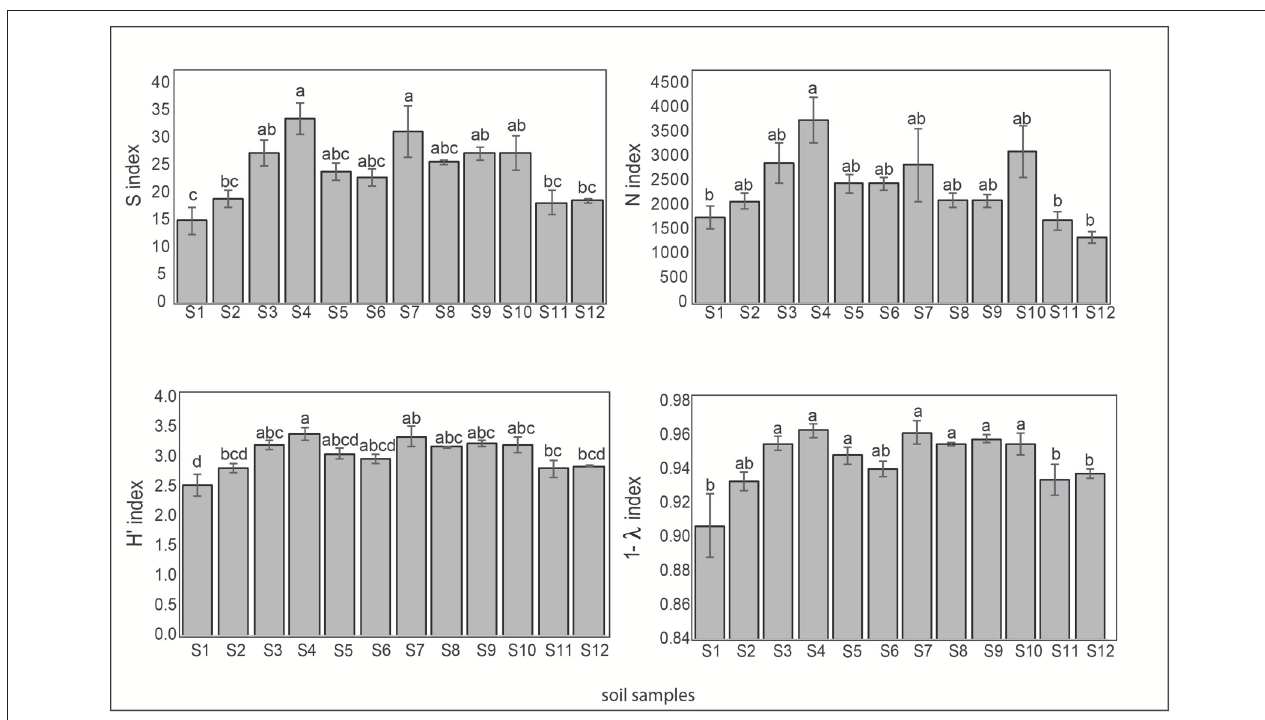
FIGURE 5 | Biodiversity indices S (species number), N (individual number), Shannon-Wiener (H) and Simpson (represented by 1- λ ) of the soil samples. Tukey’s test was used to compare treatment means, and values followed by the same letter do not differ at P < 0.05 ( n =